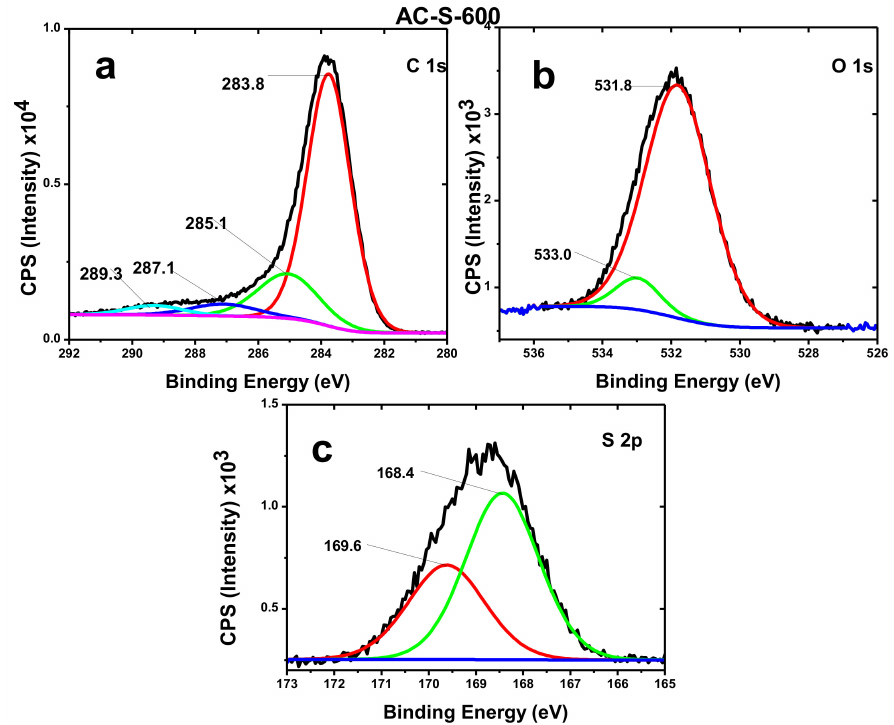
Figure 5. X-ray photoelectron spectroscopy (XPS) deconvoluted spectra of AC-S-600 activated carbon material ( a ) C 1s Carbon atom at 283.7 eV, ( b ) O 1s Oxygen atom at 531.7 eV, ( c ) S 2p Sulphur atom at 168.7